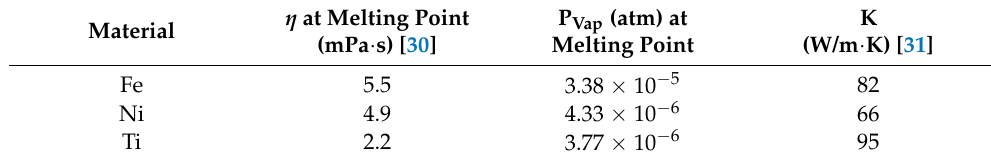
Table 5. Physical properties of Fe, Ni, and Ti.